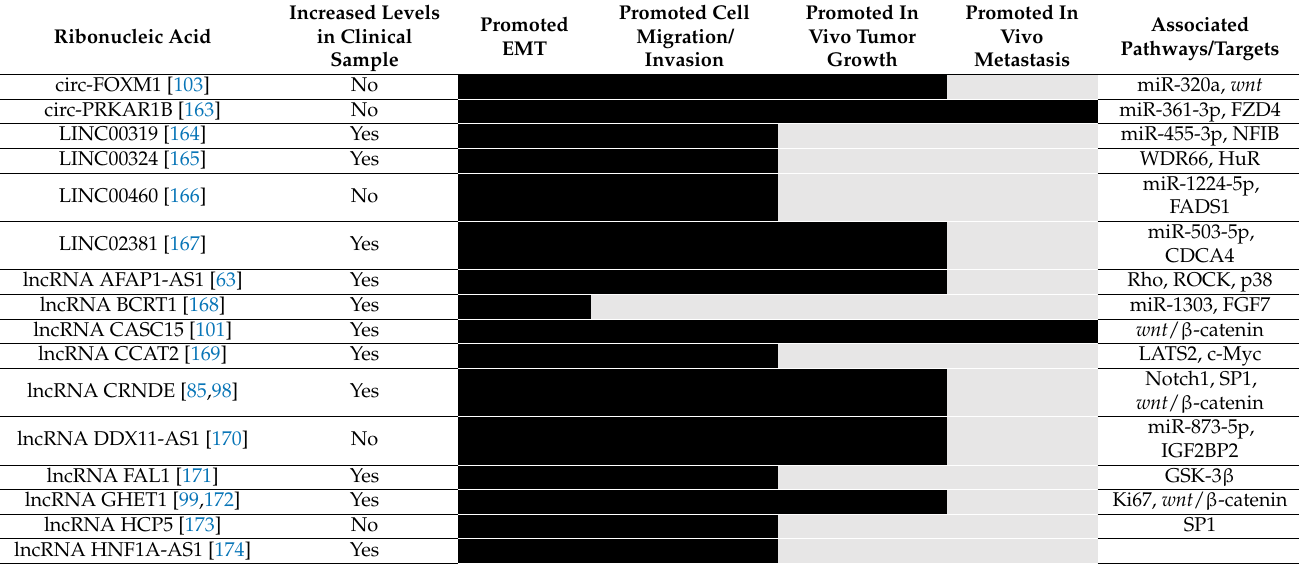
Table 3. Effects of highly expressed non-coding ribonucleic